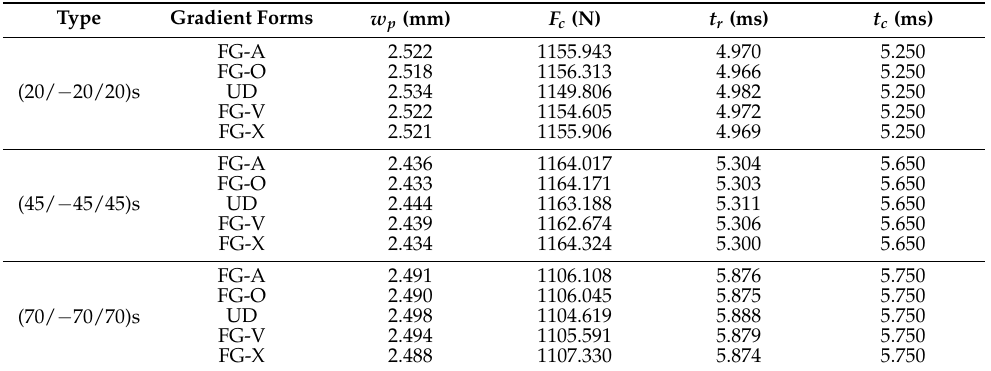
Table 5. Low-velocity impact response of the sandwich structure with various gradient forms.